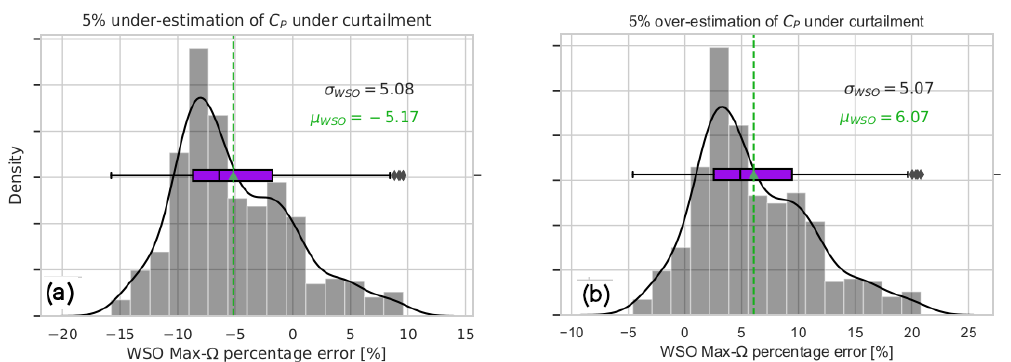
Figure 12. (a) Sensitivity of wind speed observer to correct assessment of C P under curtailment. The simulations assume “perfect knowl- edge” of C P for the normal operation and 5% uniform uncertainty for the rest of the operational range. (a) The 1Hz percentage error of WSO with Max- (cid:127) : 5% under-estimation of C P during curtailment. (b) The 1Hz percentage error of WSO with Max- (cid:127) : 5% over-estimation of C P during